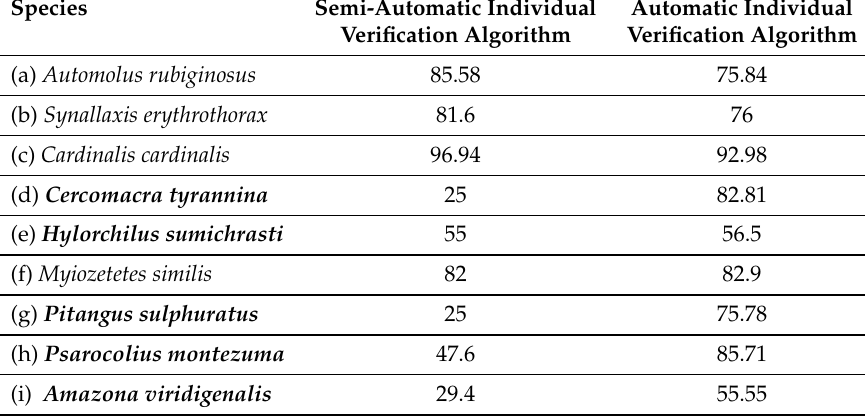
Table 5. Results of individuals identification performance test (%). Species with complex vocalizations are written in